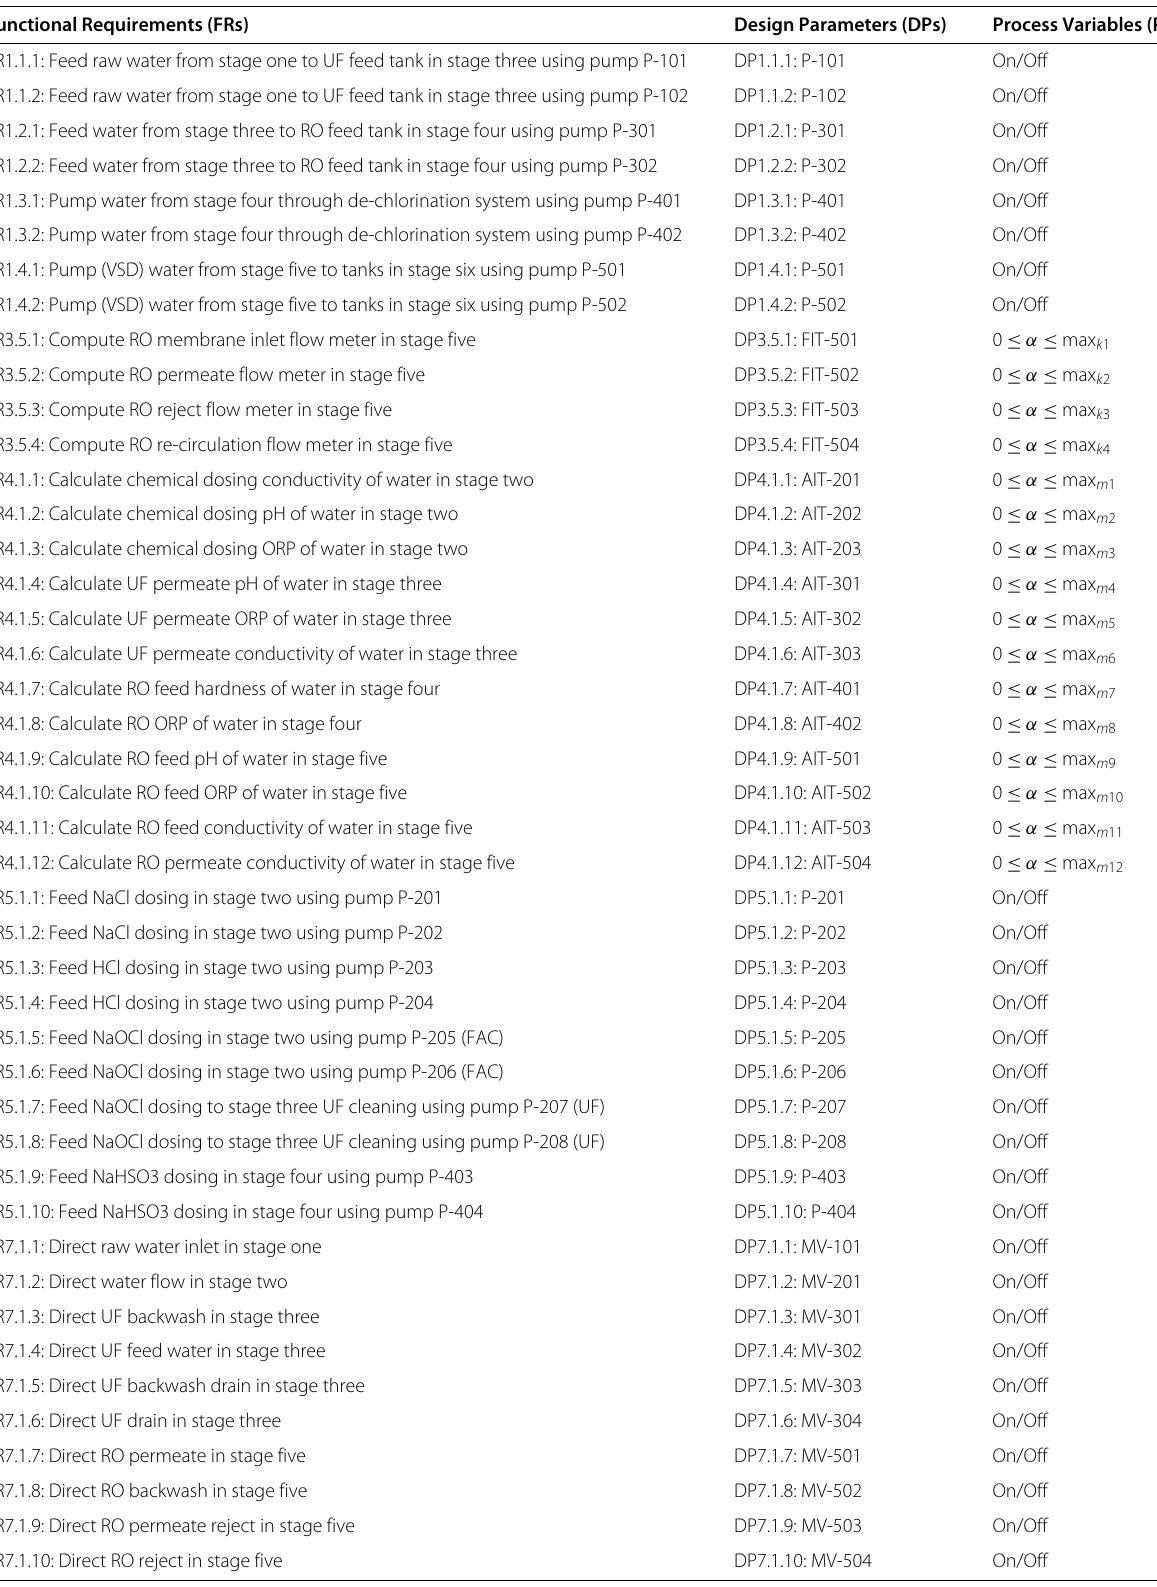
Table 2 Third-level decomposition of SWaT’s FRs and DPs Functional Requirements